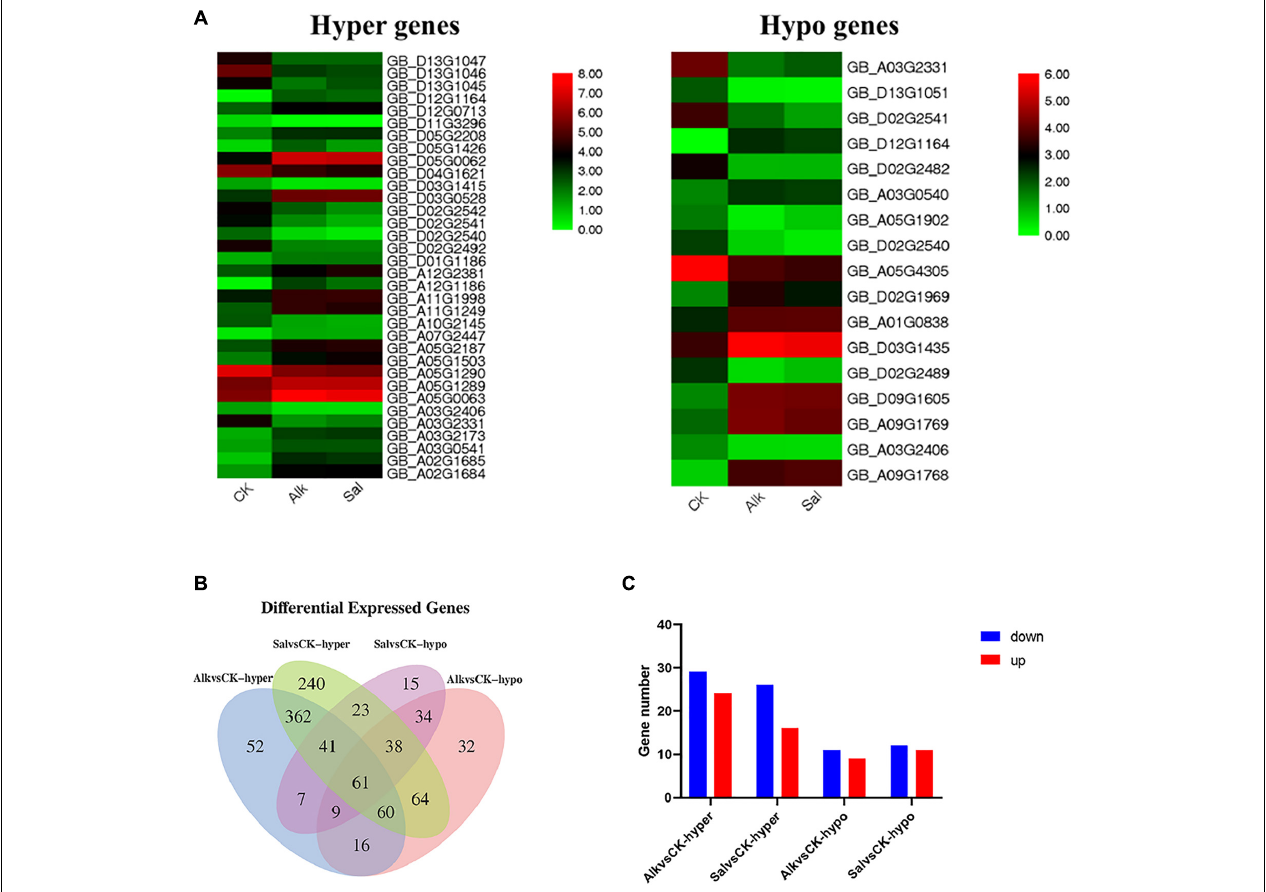
FIGURE 8 | Analysis of the methylation and transcription levels of plant hormones in response to Na + stress. (A) Heap maps of DEGs. (B) Venn diagram of DMR genes in plant hormone signal transduction under abiotic stress. (C) Gene numbers of DMRs in plant hormone signal transduction